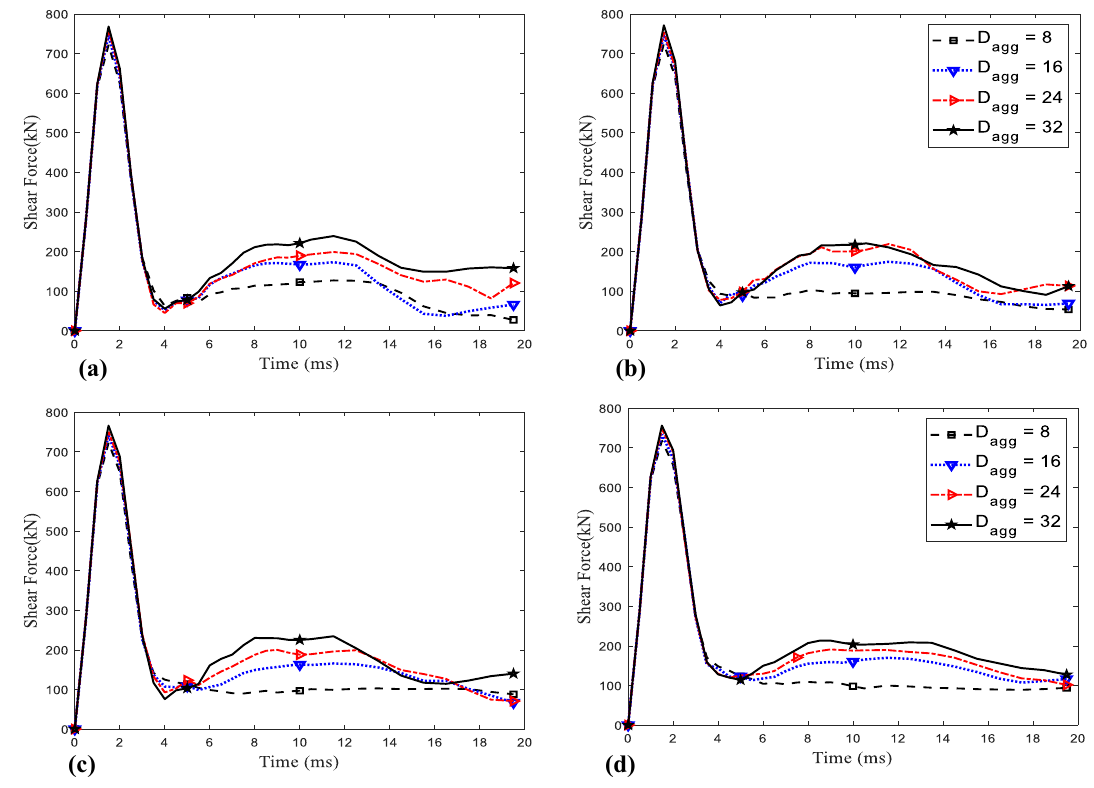
Fig. 11 Time history plots of the critical section shear force a CM1, b CM2, c CM3, d